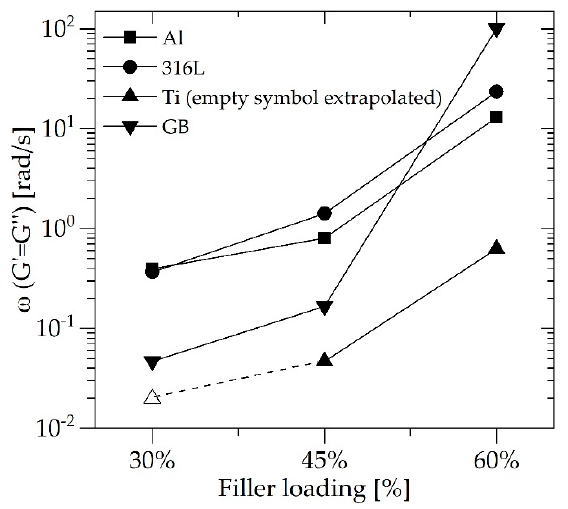
Figure 8. Crossover point ω (G ′ = G ″ ) for the composites with various loadings. The point at 30 vol.% for Ti was extrapolated from the measured results.